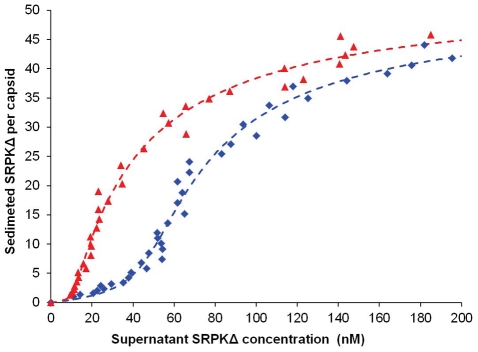
Titration of Cp183 capsid by SRPKΔ.Titrations were performed to determine the binding constant and stoichiometry of SRPKΔ for Cp183 capsids and the binding constant of SRPKΔ for Cp183 dimer. SRPKΔ was added to Cp183 assembly reactions, a mixture of capsids and residual Cp183 dimers (blue curve), or Cp183 assembly reactions that had been depleted of free dimers by SEC (red curve). Mixtures were incubated overnight at 4°C and then centrifuged to pellet capsid and bound SRPKΔ; SRPKΔ remaining in the supernatant was determined by densitometry of SDS-PAGE. Data are reported as the number of sedimented SRPKΔ molecules per capsid. Theoretical curves were fit to the data assuming equivalent non-interacting sites on capsids or dimers. On average, there were 49±3 SRPKΔ molecules per capsid binding with 31±3 nM dissociation constant and dissociation constant of 0.6±0.4 nM for each C-terminus on a free dimer.